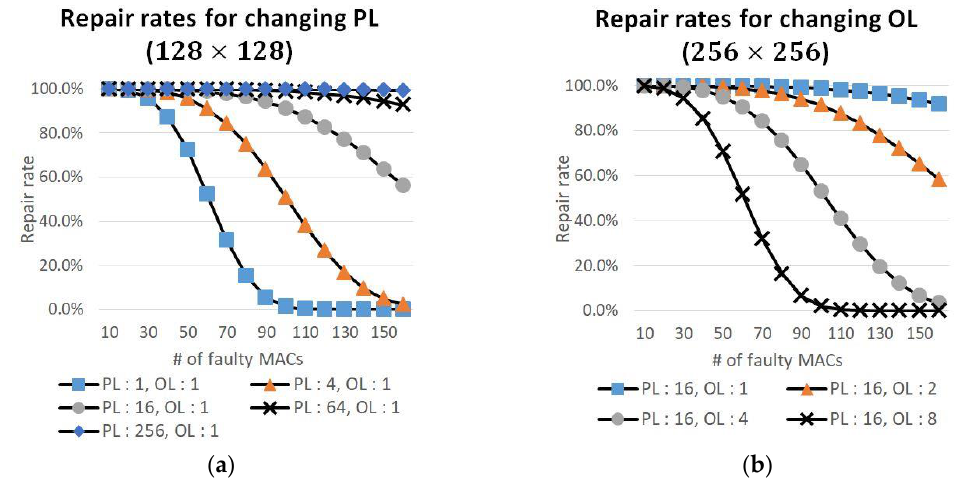
Figure 8. Repair rate comparison with various PL s and OL s: ( a ) Fix OL , change PL ; ( b ) Fix PL , change OL .